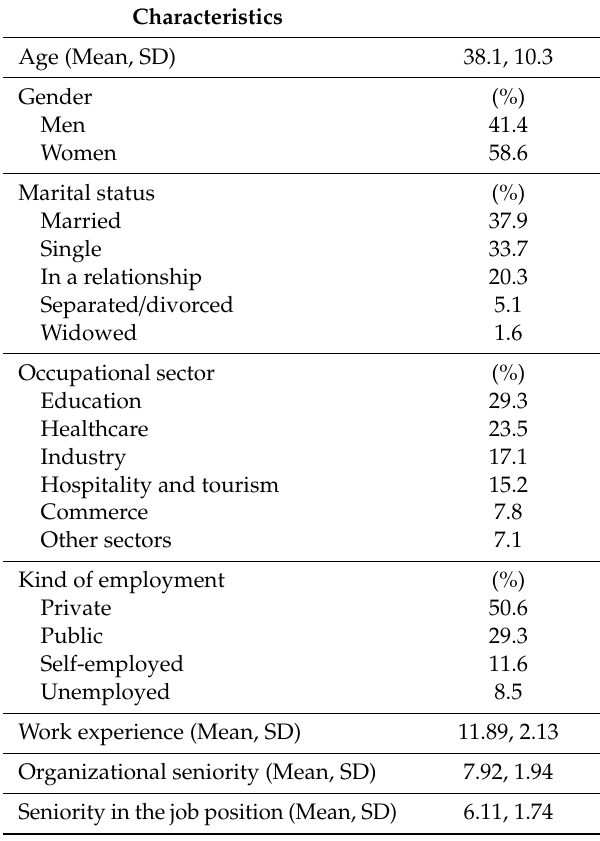
Table 1. Individual characteristics of the study